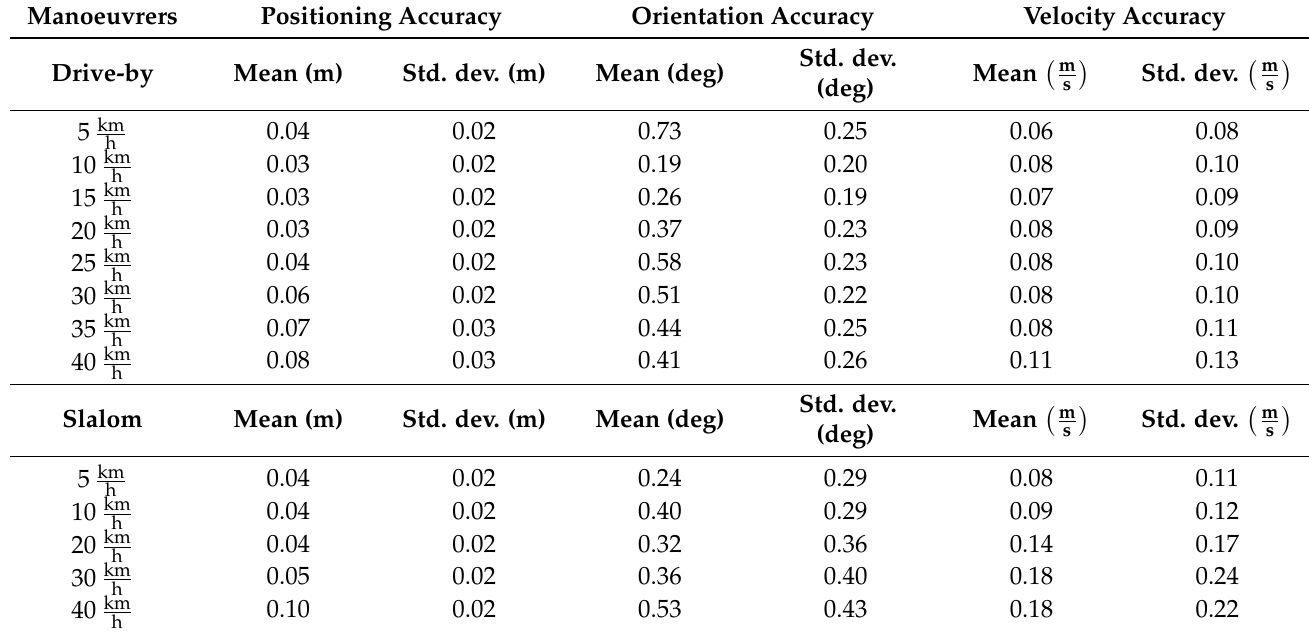
Table 2. Accuracy results for the proposed LbPM. Shown are the maneuvers, maneuverer velocity, mean deviation from the reference and Std. dev. of the corresponding errors.